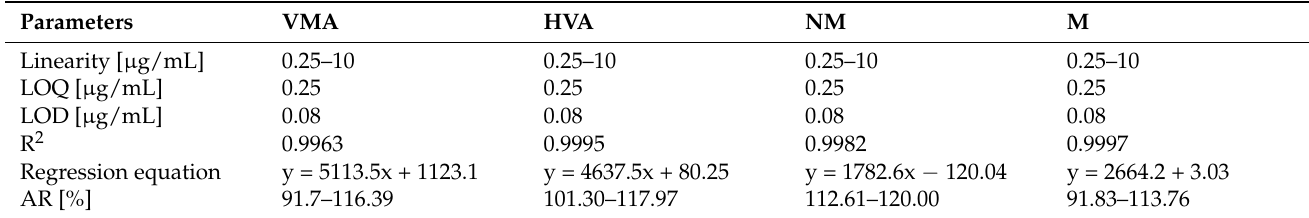
Table 3. Quantitative performance of the proposed SPE-MEKC-UV